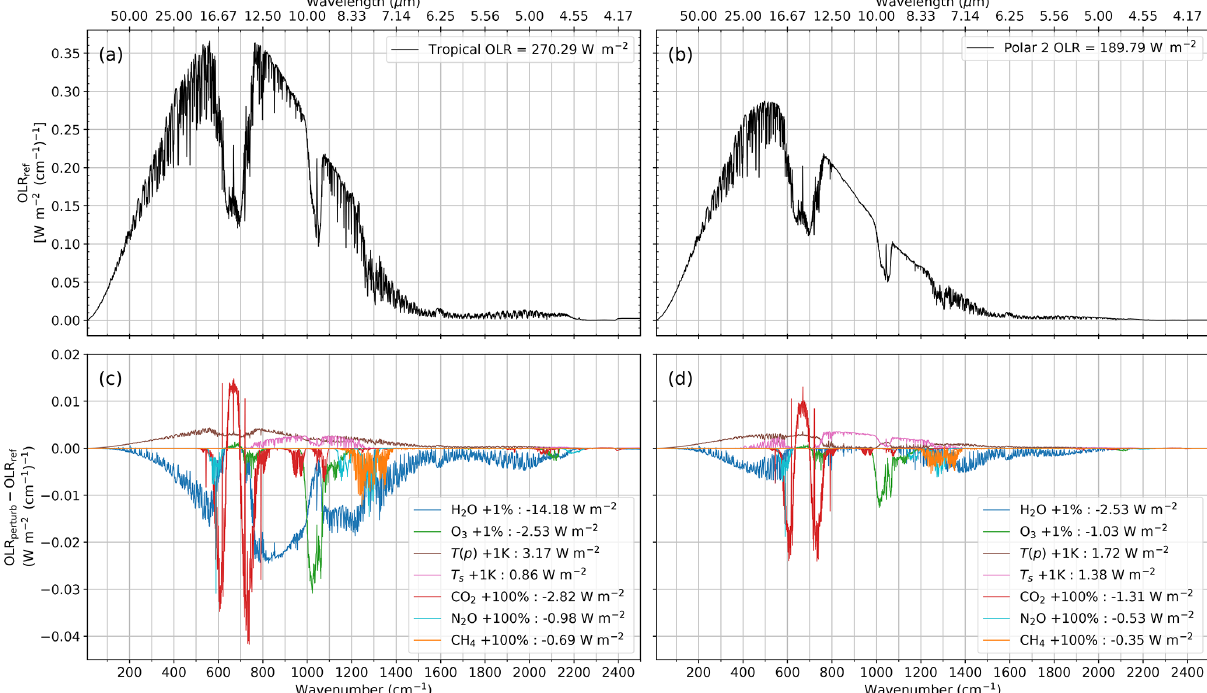
Figure 5. Spectral OLR at a spectral resolution of 1cm − 1 computed for the TIGR mean Tropical atmosphere (a) and TIGR mean Polar 2 atmosphere (b) . Corresponding OLR values spectrally integrated between 10 and 2500cm − 1 are provided in the legends. Spectral OLR sensitivity to temperature and composition change for the TIGR mean Tropical (c) and mean Polar 2 (d) atmospheres. Results are expressed as [ OLR perturb. − OLR ref. ] as a function of the wavenumber. The spectrally integrated sensitivities are specified in the legends and in Table 5. Table 5. Spectrally integrated OLR sensitivity to the variations of thermodynamic and composition variables. Variable Perturbation OLR sensitivity Tropical [Wm − 2 ] OLR sensitivity Polar 2 [Wm − 2 ] Temperature profile +1K Surface temperature +1K 0.86 Water vapor concentration +1% − 14.18 −